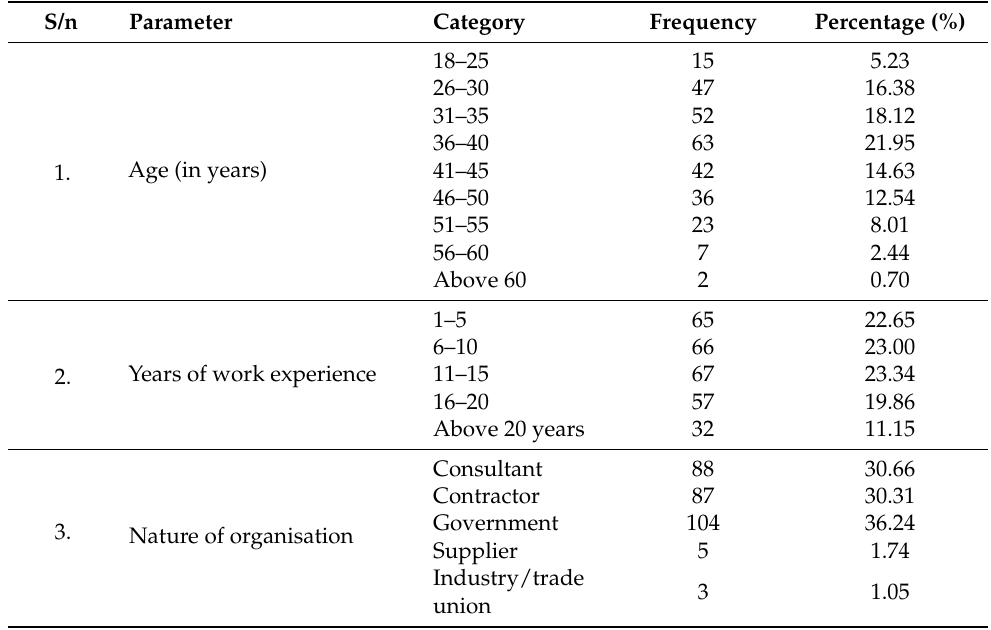
Table 1. Demographic profile of